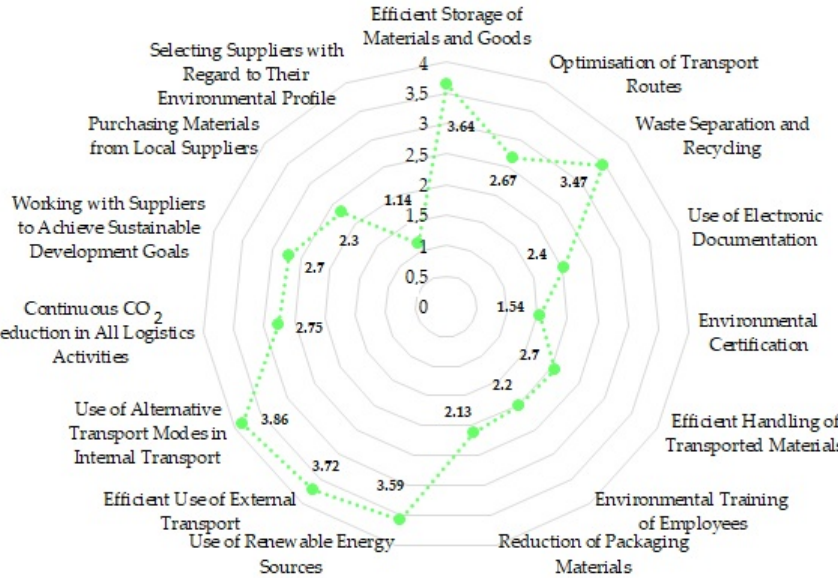
Figure 3. The data visualization about sustainability in production and logistics processes in manufacturing enterprises.